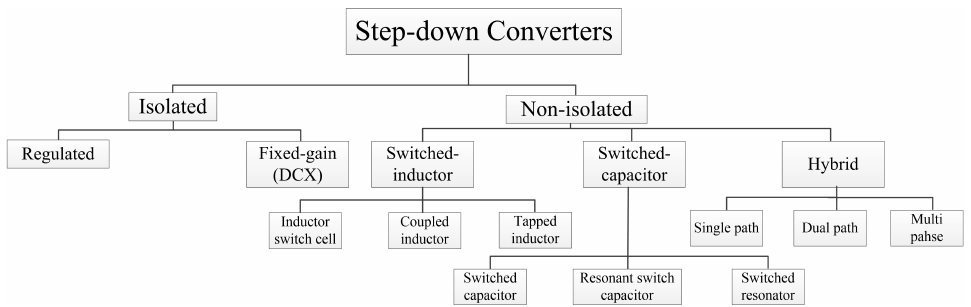
Figure 1. The step-down DC–DC converter